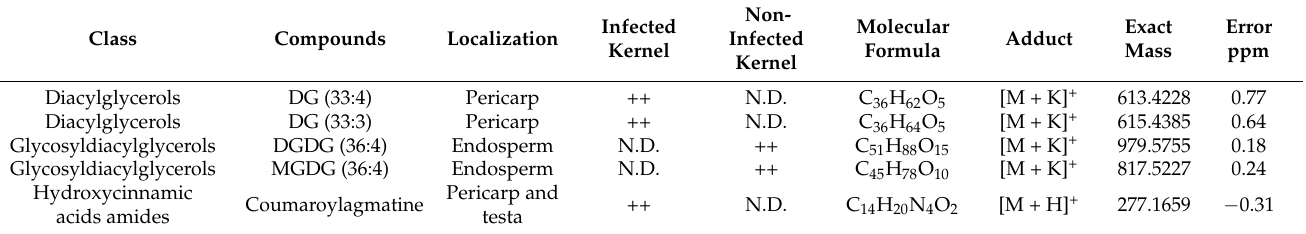
Table 1. Differentially accumulated metabolites in infected vs. non-infected kernels, whose m / z images are reported in the manuscript (qualitative abundance are reported as: N.D., not detected; ++, detected with high relative